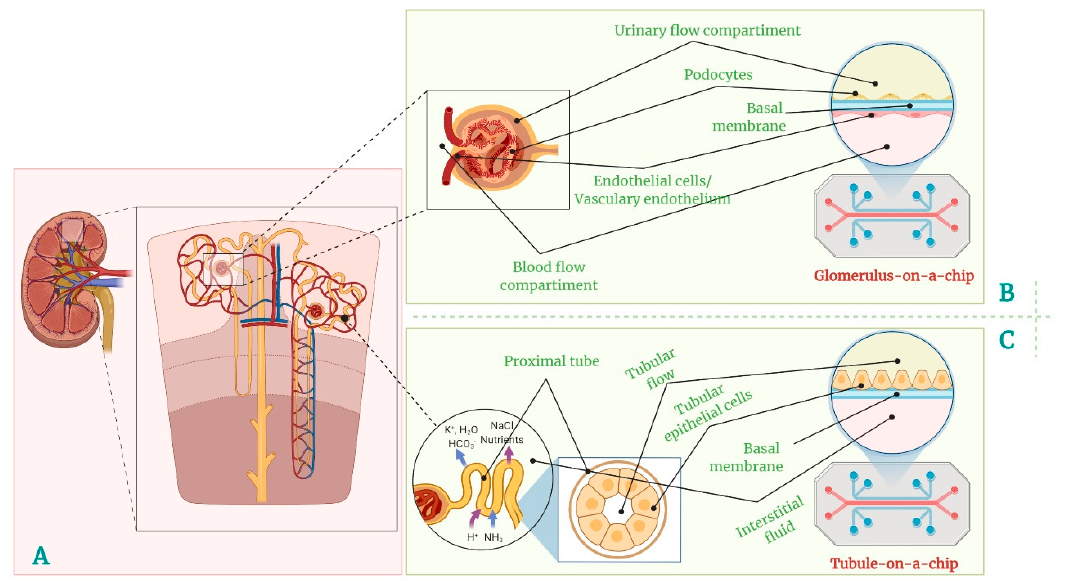
Figure 2. Complex kidney-on-a-chip for personalized medicine: ( A ) kidney and nephron, ( B ) glomerulus-on-a-chip, and ( C )